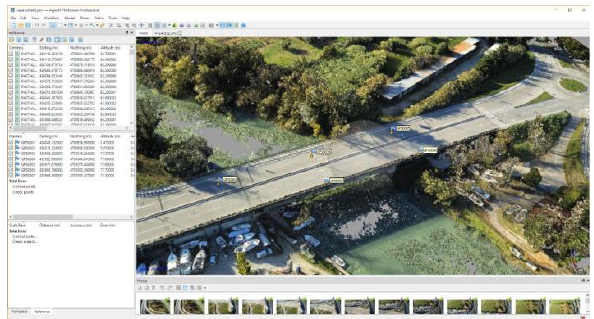
Figure 9: the 5 point GPS mismatch materials taken on site with the model directly generated by drone.